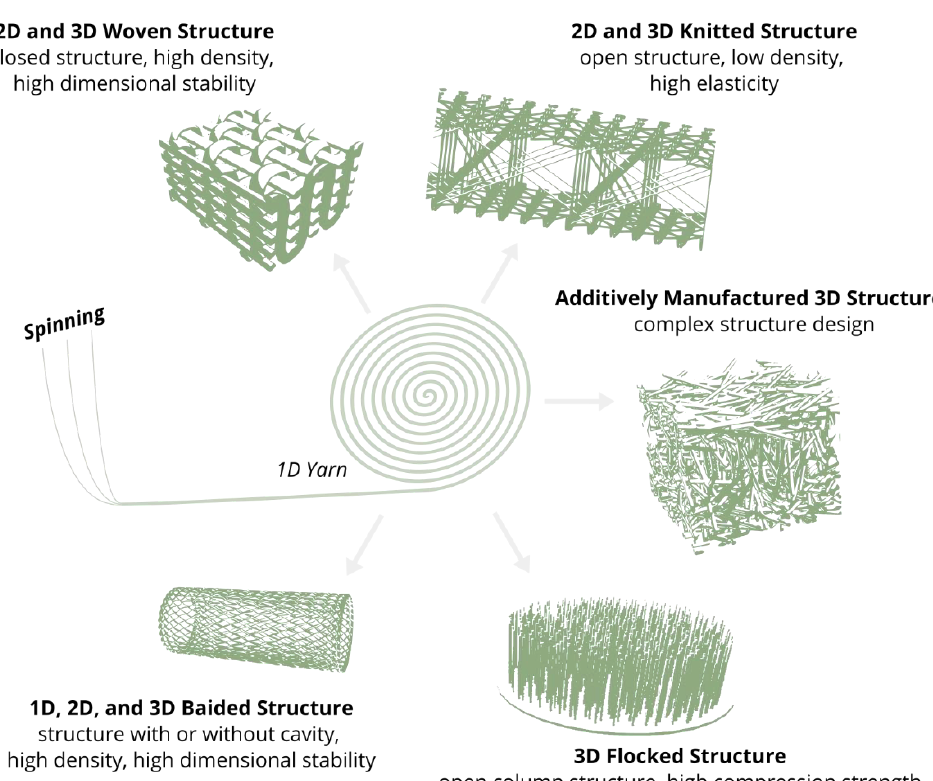
Figure 8. Collagen multifilament yarns wound on spools.